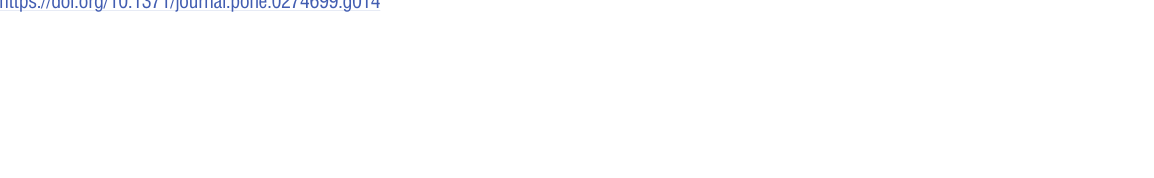
PLOS ONE | https://doi.org/10.1371/journal.pone.0274699 October 19,